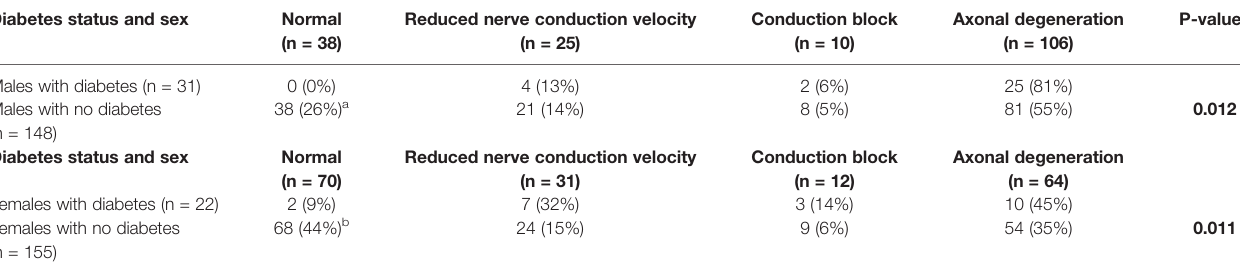
Data are presented as numbers (%). Statistical differences are detected using the Chi-square test (Pearson or Fisher´s; p-values indicated comparing all groups and with subsequent analysis below). P-values in bold indicate statistical signi fi cant. a Signi fi cantly more males without diabetes among those with normal electrophysiology. b Signi fi cantly more females without diabetes among those with normal electrophysiology.